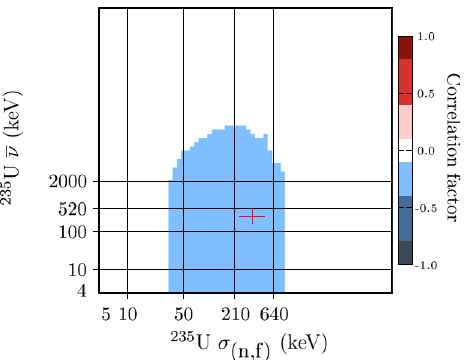
Fig. 7. As in Figure 4: correlation sub-matrix between the fi ssion cross section of 235 U and the elastic cross section of 238